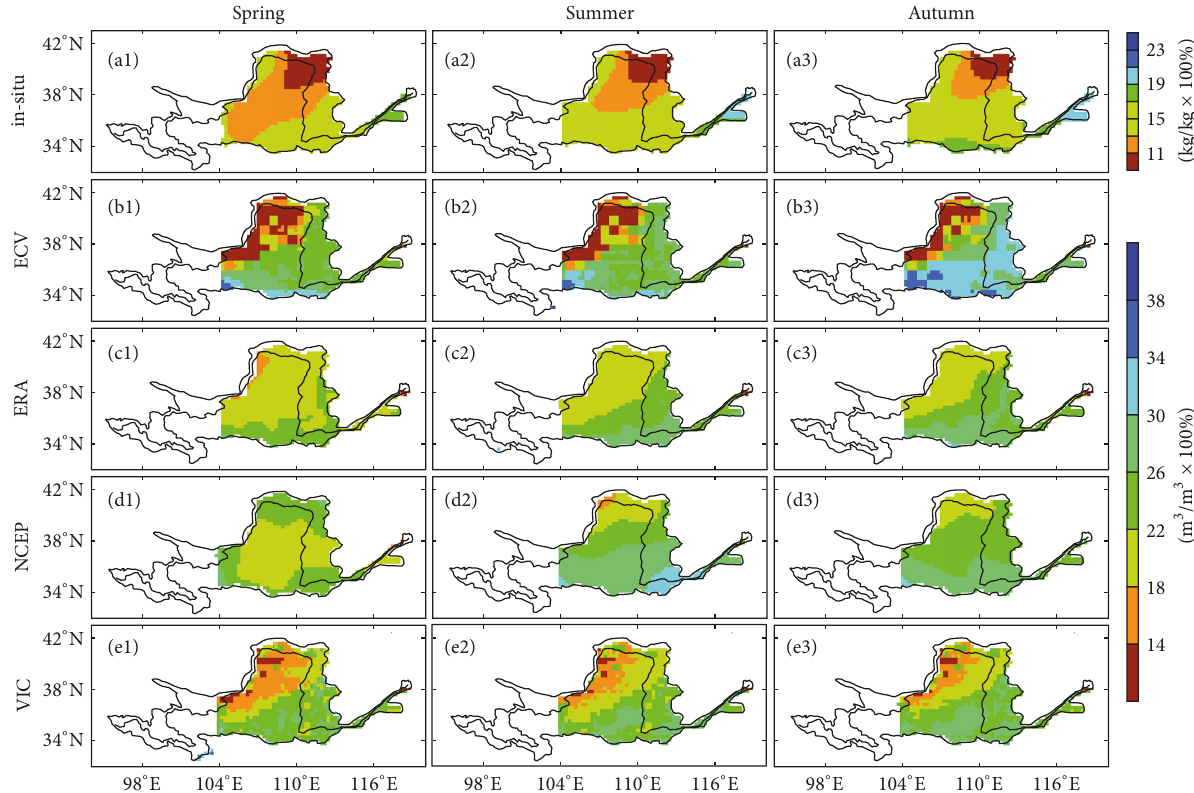
Figure 2: The spatial distributions of the four soil moisture datasets, which are climatological averages in each season computed from the time period of 1988–2010: a (1) –a (3) are for SM ECV , b (1) –b (3) are for SM ERA , c (1) –c (3) are for SM NCEP , and d (1) –d (3) are for SM VIC .